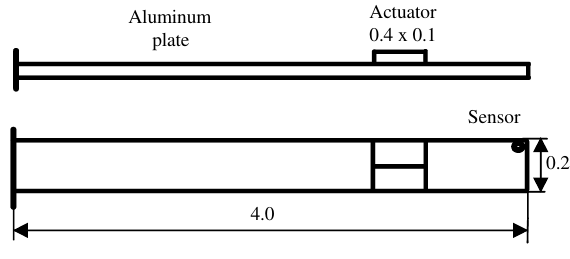
Fig 1. Aluminum plate with piezoelectric actuators A multilayered SHELL99 element is used